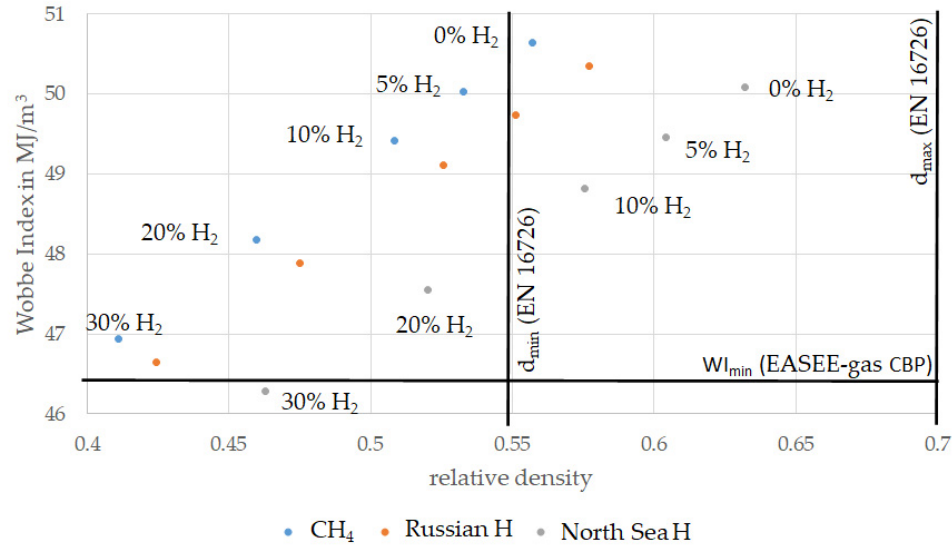
Figure 2. Hydrogen admixture to natural gases in a gas quality diagram. All values given in the ISO reference system 15 °C/15 °C.